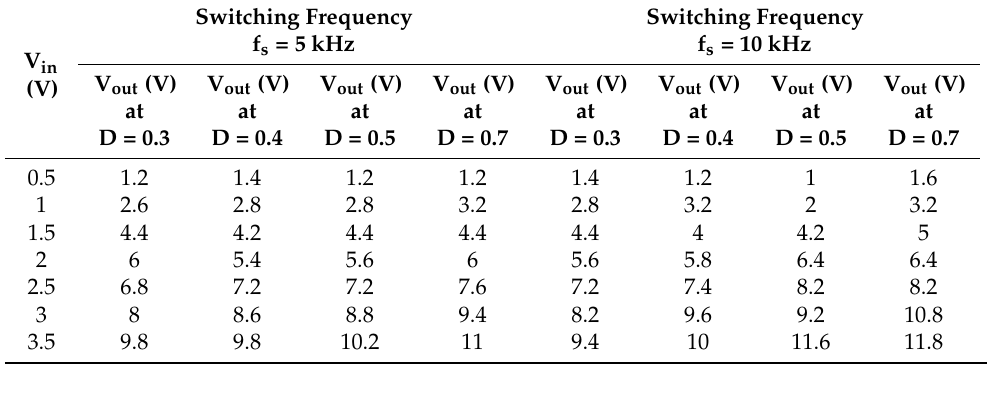
Table 11. Comparison of output voltages at different duty cycles and with f s = 5 kHz and f s = 10 kHz.